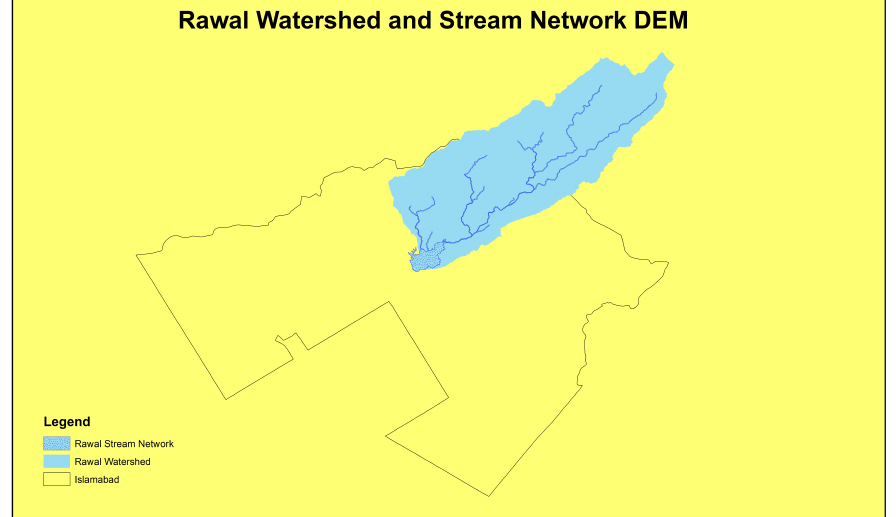
Figure 2. Study area map for the Rawal watershed located in Islamabad,